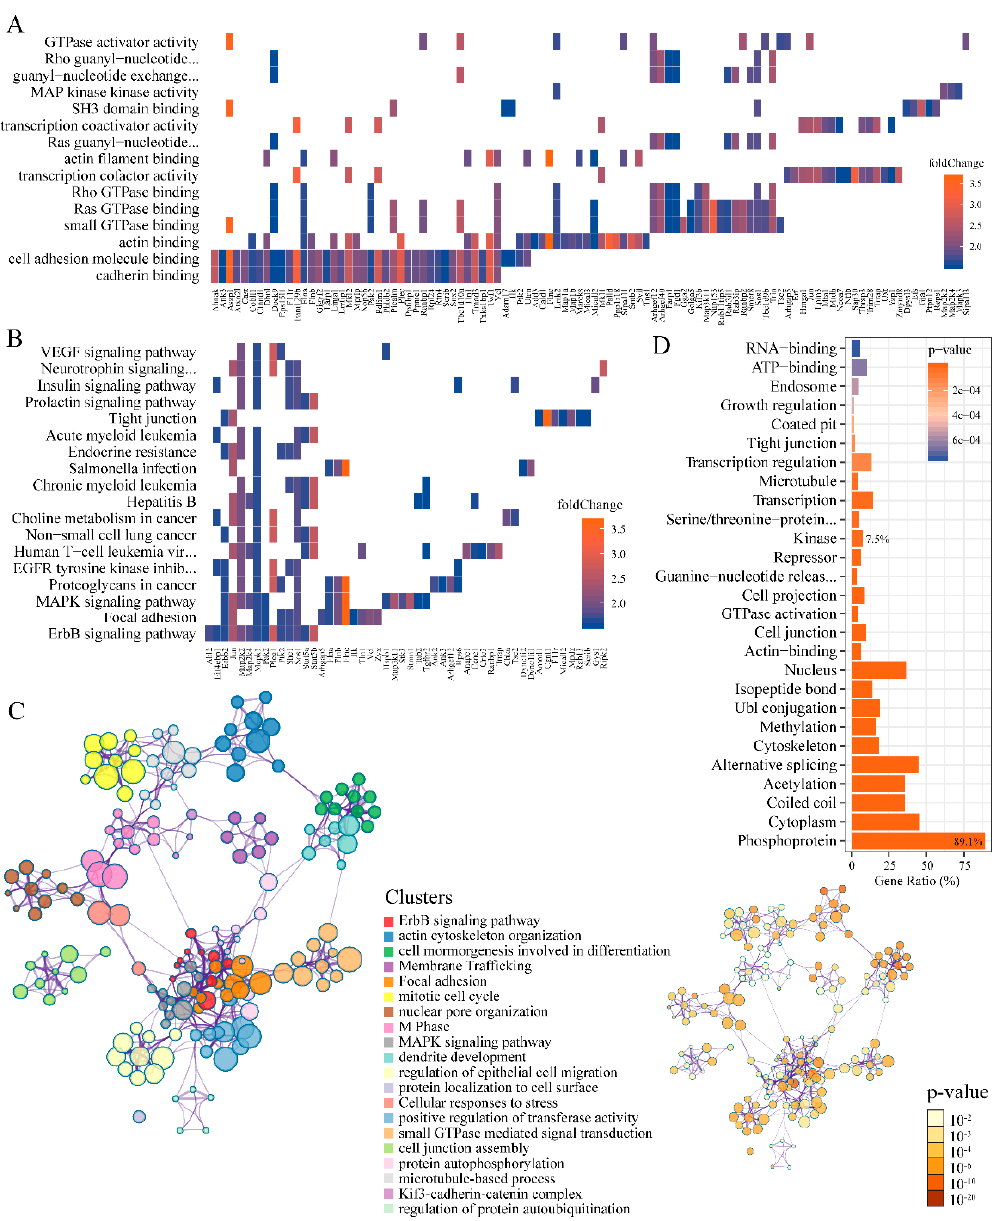
Figure 2. The functional enrichment of SPRY-altered phosphoproteins in mouse mammary stromal fibroblasts. ( A ) Heat plot of Gene Ontology (GO)-enriched molecular function of the up-regulated phosphoproteins. The color of the blocks indicates the fold change of each enriched protein; ( B ) Heat plot of Kyoto Encyclopedia of Genes and Genomes (KEGG) pathway enrichment of the up-regulated phosphoproteins. The color of the rectangle indicates the fold change of each enriched protein; ( C ) The complex network of enriched terms by Metascape, where terms with a similarity more than 0.3 are connected by edges. Nodes that share the same cluster ID are in the same color, and typically close to each other. The p -value of each term is also shown; ( D ) Protein class distribution of phosphorylation altered proteins. The phosphoproteins (370) occupy 89.1% and kinases (31) occupy 7.5%. The single-item enrichment p -value less than 0.001 are shown and ranked by p -value.